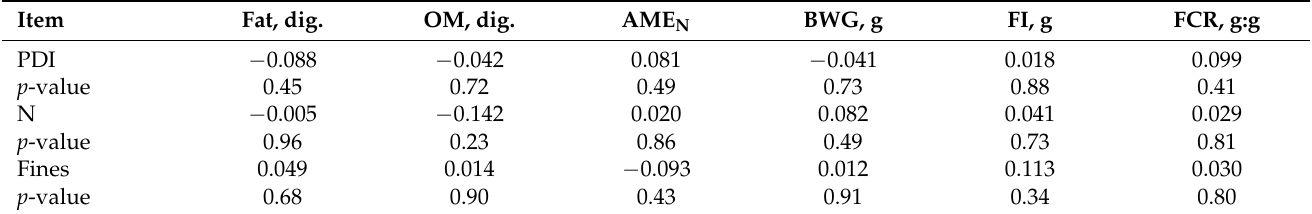
Table 14. Pearson’s correlations between feed physical proprieties and digestible and performance values of broilers in grower feed phase, 15 to 28 d.